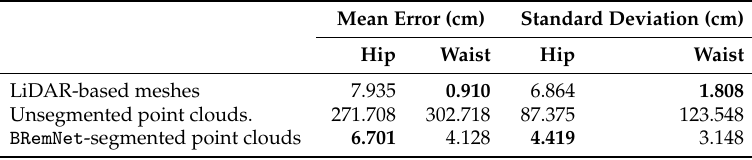
Figure 9. Linear regression of the estimated waist and hip against the actual measurements. BRemNet -Point cloud in blue and LiDAR-based mesh in red. ( a ) Waist and ( b ) hip. Table 4. Waist and hip measurement